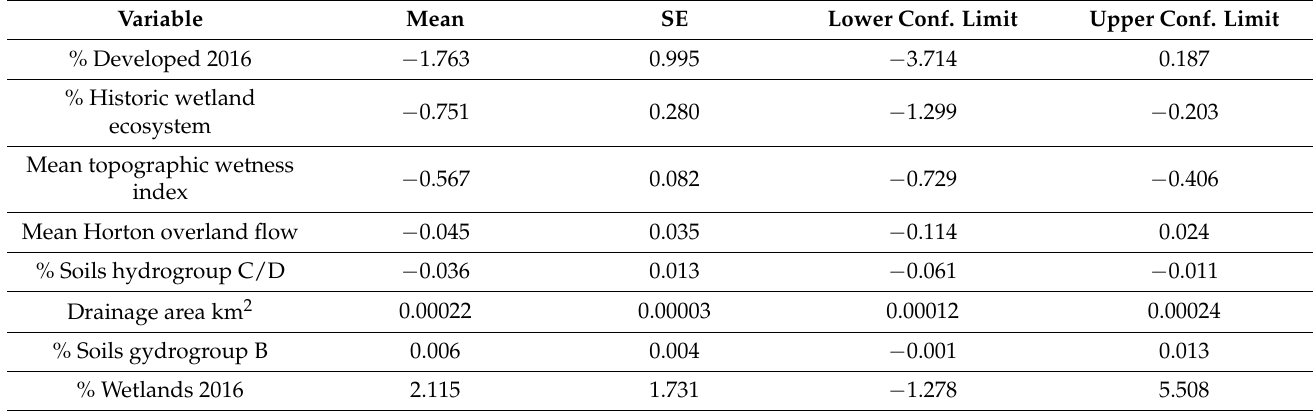
Table 5. Standard coefficients of variables included in ∆ AICc ≤ 2 model set with 95% confidence intervals. % Cherty red clay not included in AICc models.